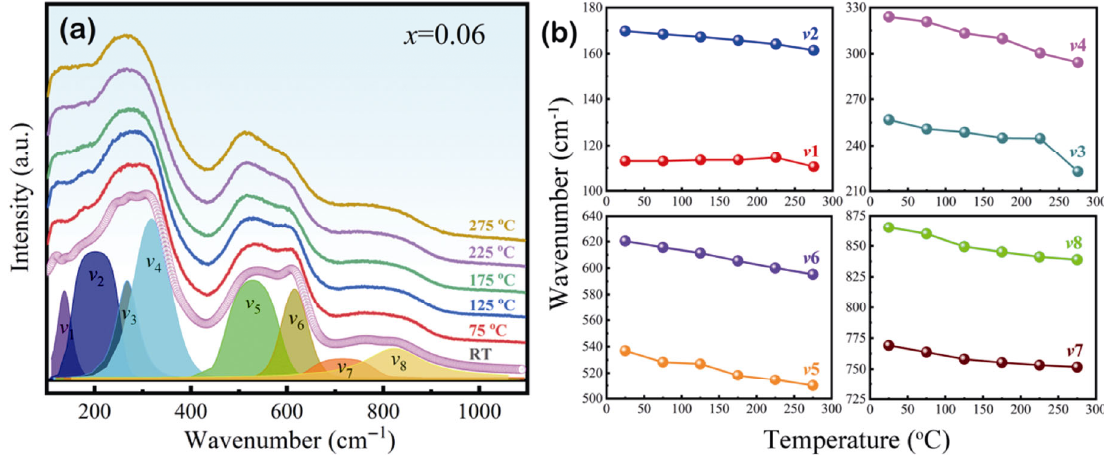
Fig. 5 (a) Raman spectra and (b) wavenumbers of Raman peaks from ν 1 to ν 8 of BNS 0.245 − 1.5 x (cid:0) 0.5 x B 0.325+ x T ceramics with x = 0.06 at different